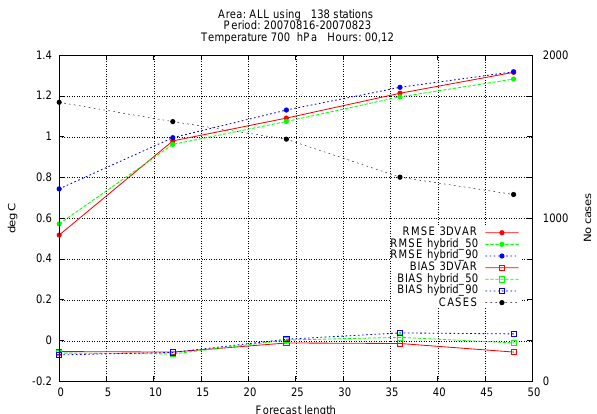
Fig. 8. Bias and RMS (Root Mean Square) verification scores for 700hPa temperature forecasts as verified against radiosonde obser- vations averaged over the period 16–22 August 2007 as a function of forecast length. Experiments 3DVAR (3D-Var, red curves), hy- brid_90 (10% 3D-Var and 90% ensemble covariance, blue curves) and hybrid_50 (50% 3D-Var and 50% ensemble covariance, green curves). The curve marked CASES indicates the number of ob- served values for the verification.